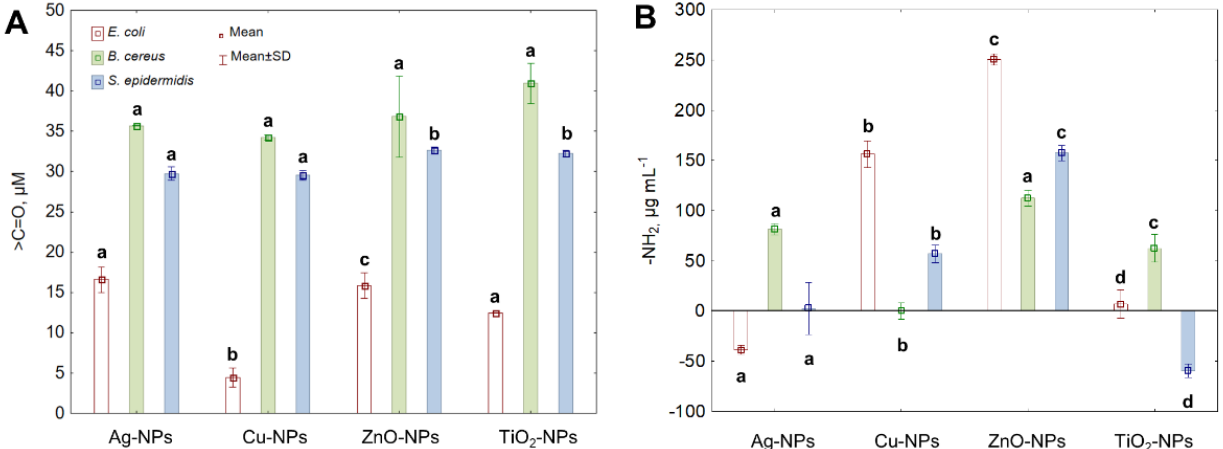
Figure 4. The content of >C=O ( A ) and -NH 2 ( B ) in E. coli , B. cereus and S. epidermidis cells exposed to NPs at an IC 50 value (mean ± SD/SE; n = 3). Means with the same letter(s) are not significant at p < 0.05 between the control and NPs-treated cells.